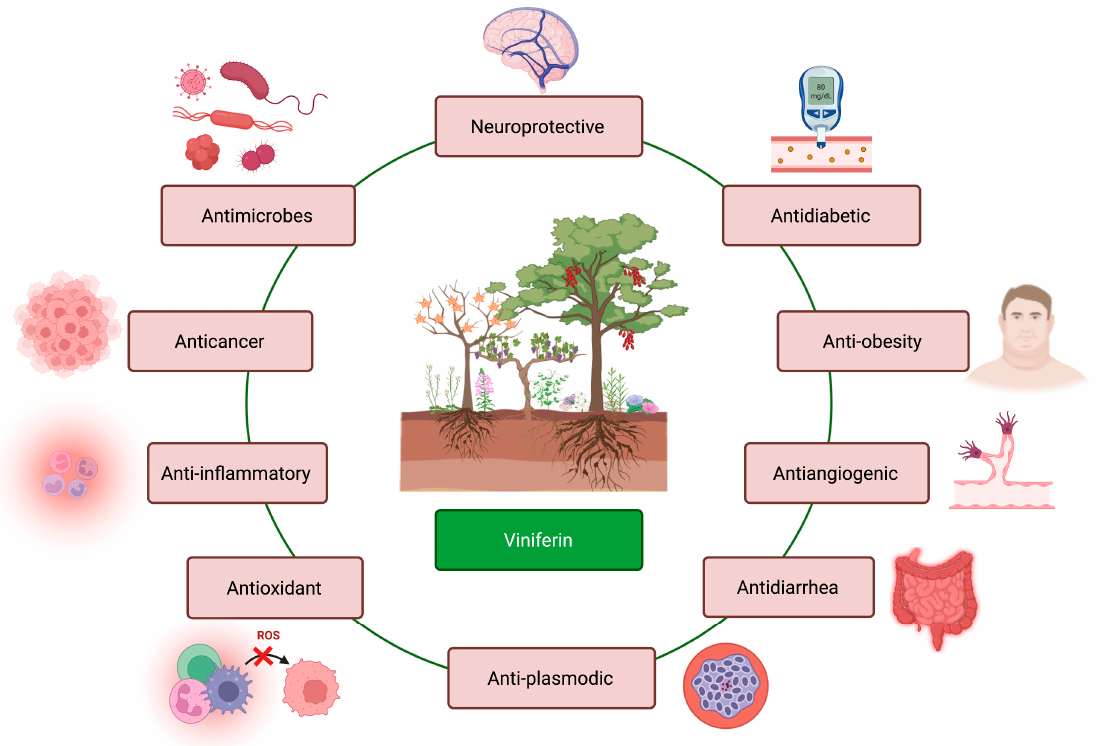
Figure 3. Biological attributes of viniferin against multiple conditions.